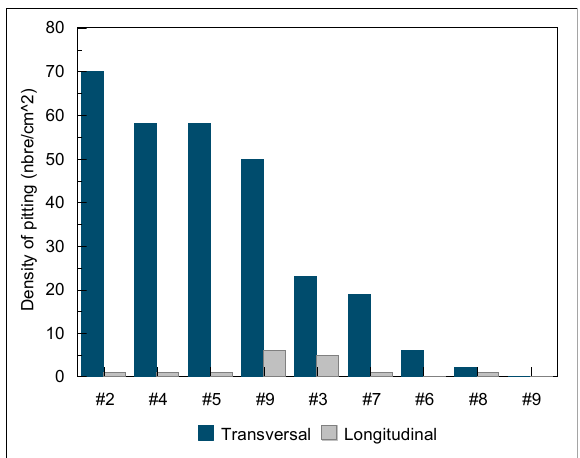
Figure 23. Pitting test in the transverse and longitudinal faces for various grades of nickel alloys. Test medium FeCl3 0.5M at 50 °C, 2 h.